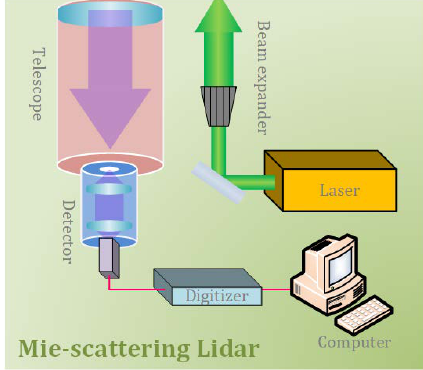
Figure 1. The sketch of Mie-scattering lidar